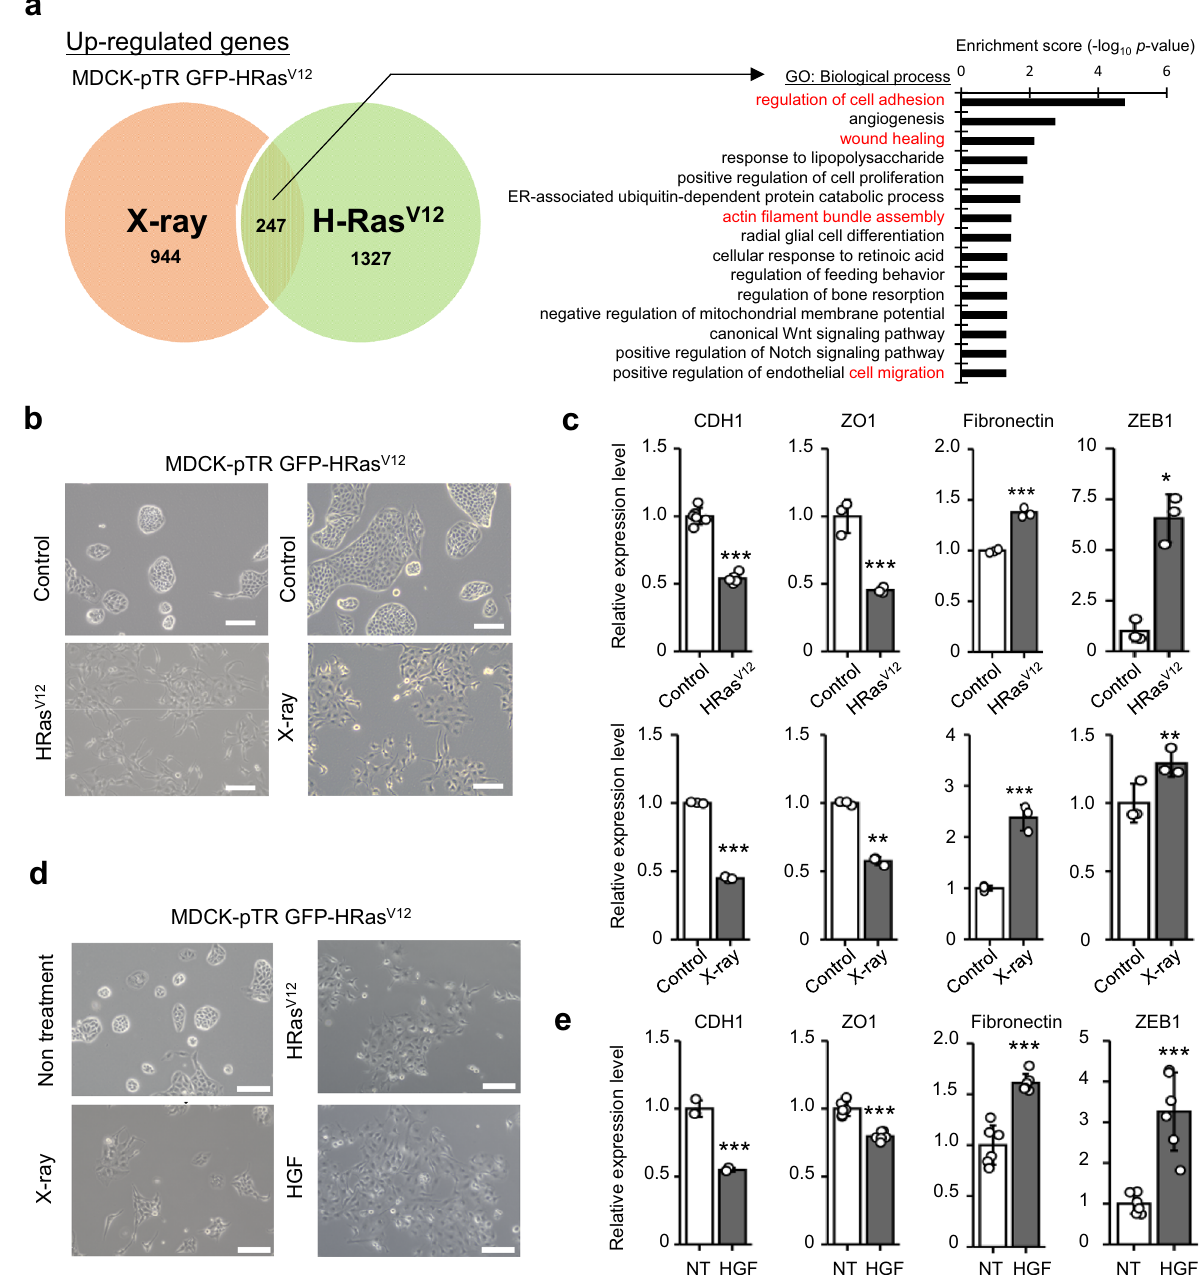
Fig. 3 HGF derived from senescent cells induces EMT of Ras V12 MDCK cells. a Venn diagram indicates upregulated genes that presented at least a twofold signi fi cant change in expression in MDCK-pTR GFP-Ras V12 cells treated with CM of X-ray- (red) and oncogene-induced senescent IMR-90 cells (green) than in control cells. Out of 2518 genes detected in two samples, 247 were commonly upregulated in both. An enrichment test using GO analysis was performed with those commonly upregulated genes in MDCK-pTR GFP-Ras V12 cells. The 15 most enriched terms within the biological process of GO are described in the bar graph. b The appearance of MDCK-pTR GFP-Ras V12 cells treated with CM derived from oncogene- or X-ray-induced senescent IMR-90 cells for 24 h. Scale bar, 100 μ m. c RT-qPCR analysis of EMT markers in treated MDCK-pTR GFP-Ras V12 cells (H-Ras: V12 CDH1, P < 0.001; ZO1, P = 0.0016; fi bronectin, P < 0.001; ZEB1, P = 0.0018), (X-ray: CDH1, P < 0.001; ZO1, P < 0.001; fi bronectin, P < 0.001; ZEB1, P = 0.044). d The appearance of nontreated MDCK-pTR GFP-Ras V12 cells, MDCK-pTR GFP-Ras V12 cells treated with CM derived from oncogene-induced senescent IMR-90 cells, X-ray- induced senescent IMR-90 cells, or cells treated with 20 ng/ml HGF for 24 h. Scale bar; 100 μ m. e RT-qPCR analysis of EMT markers in MDCK-pTR GFP- Ras V12 cells treated with 20 ng/mL HGF (CDH1, P < 0.001; ZO1, P < 0.001; fi bronectin, P < 0.001; ZEB1, P < 0.001). CDH1 and ZO1 are shown as epithelial markers ( c , e ). Fibronectin and ZEB1 are shown as mesenchymal markers ( c , e ). Representative data from three independent experiments are shown. Error bars indicate the mean ± standard deviation of three independent measurements for all graphs. * P < 0.05, ** P < 0.01, or *** P < 0.001 by the unpaired two- sided t test ( c , e